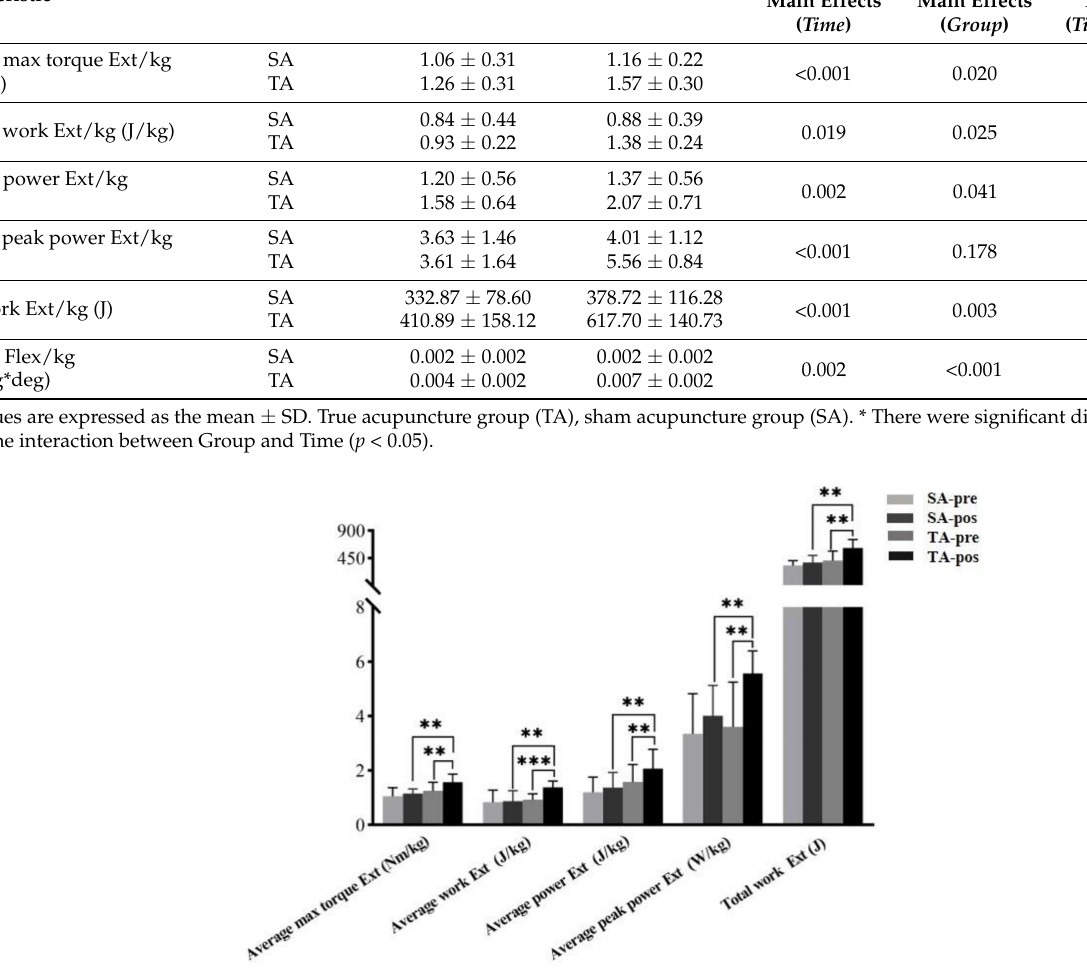
Table 2. Mean ± SD of each variable for knee extension (Ext) before and after acupuncture in TA and SA group. Characteristic Treatment Pre Post